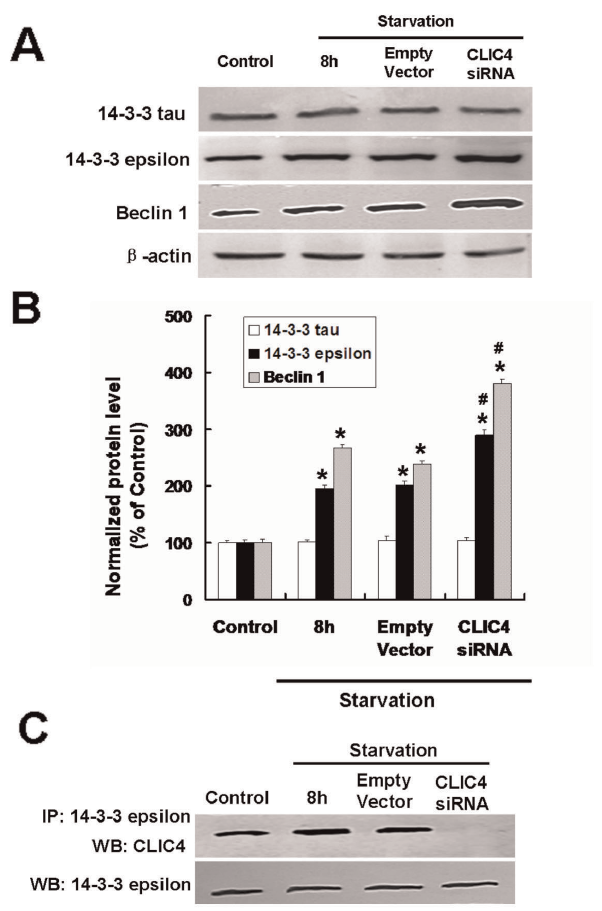
Figure 7. Enhanced autophagy by CLIC4 siRNA transfection is associated with interaction between Beclin 1 and 14-3-3 epsilon. U251 cells transfected with a plasmid encoding empty vector or CLIC4 siRNA vector for 24 h. (A) Western blot analysis of 14-3-3 tau, 14-3-3 epsilon and Beclin 1 expression in U251 cells incubated with EBSS for 8 h. (B) Densitometric analysis of normalized 14-3-3 tau, 14-3-3 epsilon and Beclin 1. Standard error represents three independent experiments. * P , 0.05 versus control group and # P , 0.05 versus starvation group. (C) Co-immunoprecipitation of 14-3-3 epsilon and CLIC4 in U251 cells under starvation conditions.